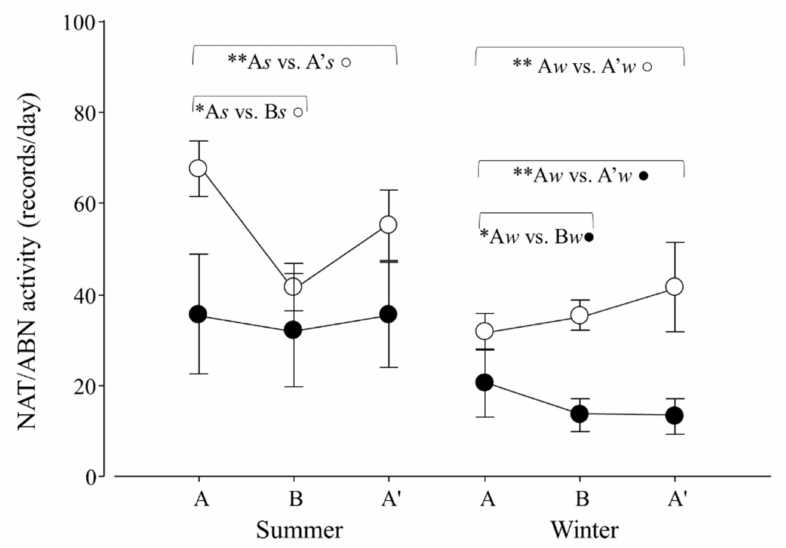
Figure 7. Natural (NAT, ) and abnormal activity (ABN, • ) per day of adult Tamandua tetradactyla (cid:35) ( n = 6 females and 6 males) exposed to semi-controlled conditions, in response to seasonal transports (applied in B) during summer and winter. The ABA experimental design applied: day 0 (previous- stage A), days 1 and 2 (disturbance—stage B) and day 3 (posterior-stage A (cid:48) ). Behaviour was recorded every 5 min (252 records/day/individual), and number of activity records per day during each stage per season was calculated. Asterisks indicate significant differences between stages during seasons for all individuals (* A s (cid:54) = B s , ** A s (cid:54) = A (cid:48) s , ** A w (cid:54) = A (cid:48) w , * A w (cid:54) = B w • , ** A w (cid:54) = A (cid:48) w • ; p values (cid:35) (cid:35) (cid:35) in the text). Results are expressed as the mean ± SEM.